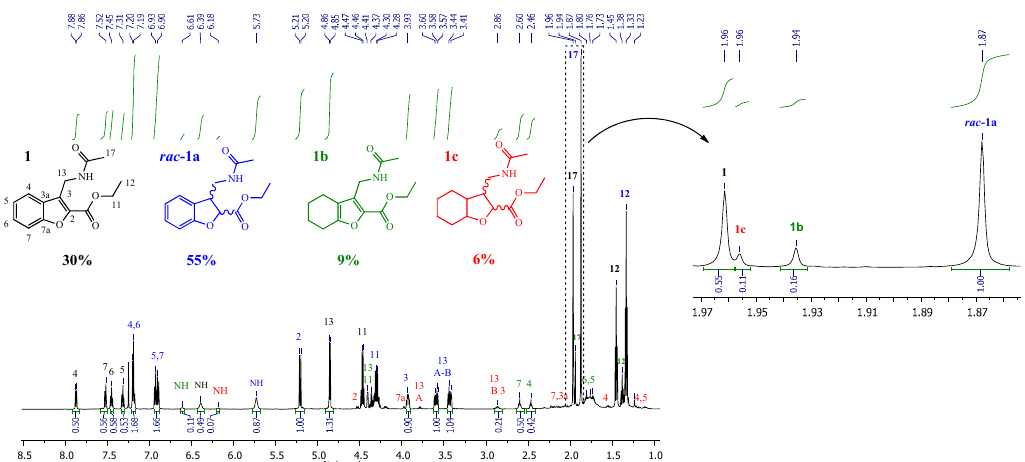
Figure 1. Variation in the hydrogenated products obtained (%) from compound 1 at 24 h due to the effect of the S/C ratio (entries 1–4, Table 2).